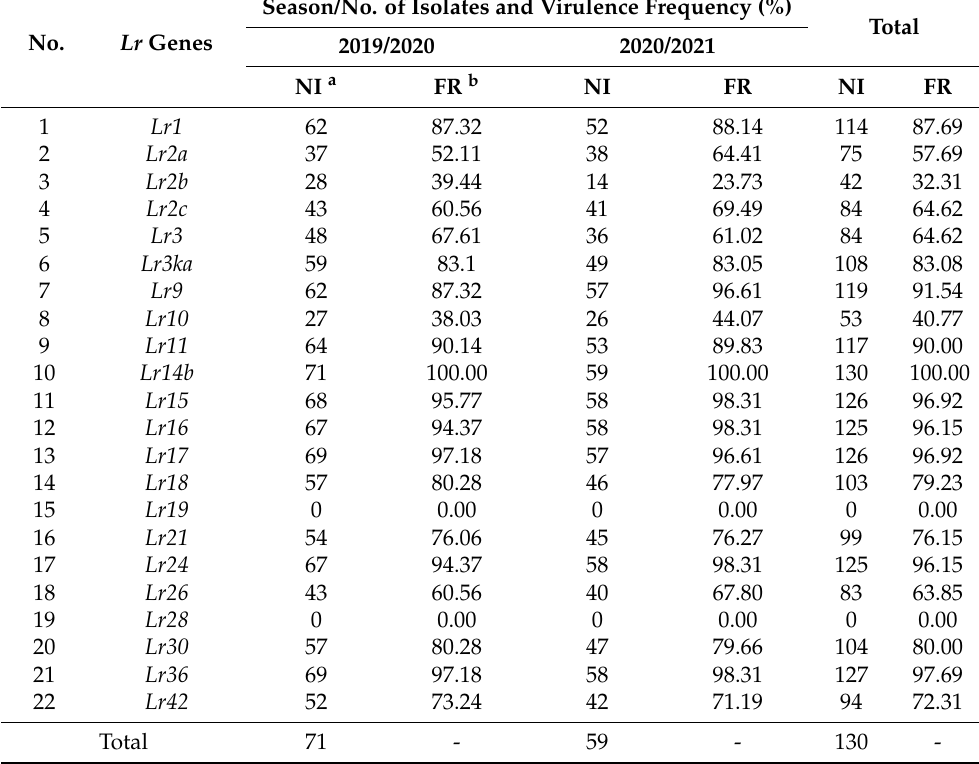
Table 6. Number and frequency (%) of Puccinia triticina virulent isolates to 22 Lr genes